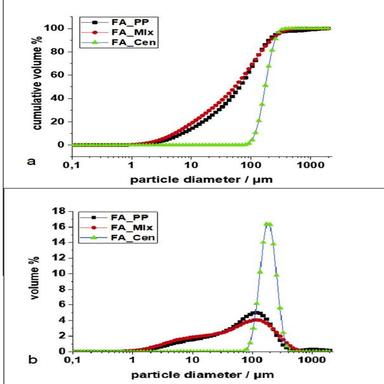
Particle size distribution cumulative (a) and volumetric (b).